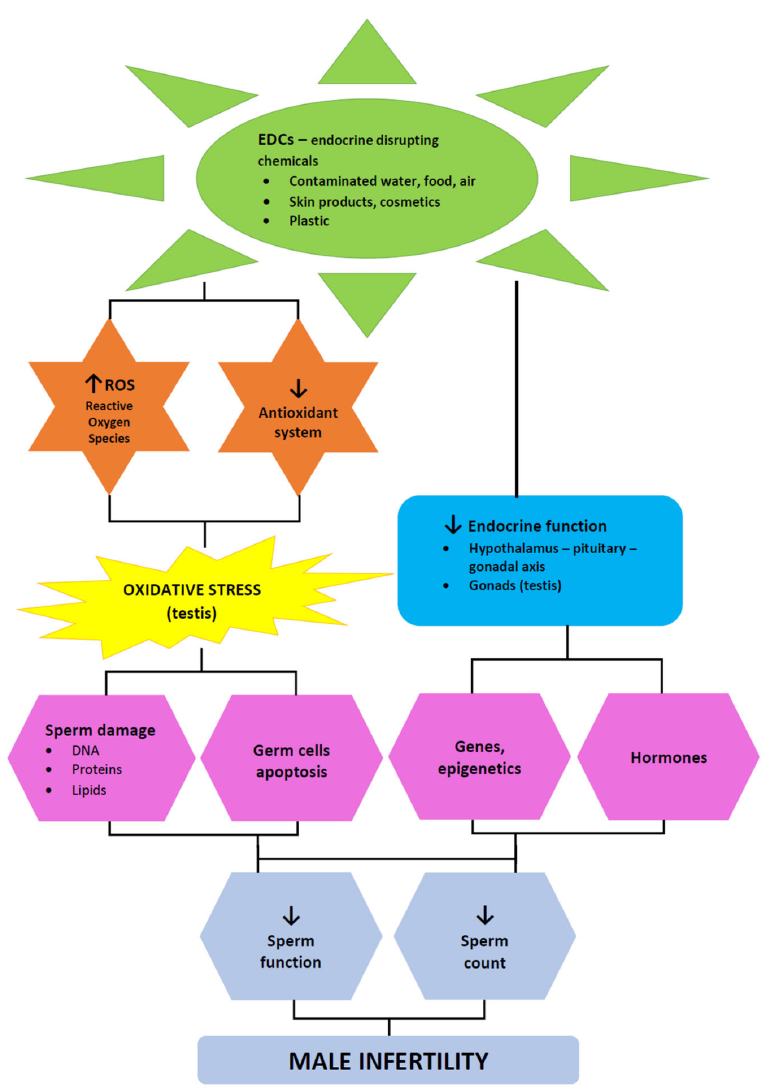
Figure 2. Mechanisms of action of endocrine ‐ disrupting chemicals (EDCs) on male fertility. EDCs may be able to bind to receptors on human spermatozoa and change sperm functions, according to mounting evidence [76]. The interaction between estrogenic compounds and nongenomic receptors for estrogen on human sperm membranes has been demonstrated. The nongenomic receptor for estradiol (E2), which is located on the sperm plasma membrane, mediates the effects of this hormone on sperm’s intracellular calcium concentrations and biological response to progesterone (P). It was shown that 17 β E2 expresses an inhibitory effect on P ‐ mediated calcium influx and acrosome reaction (AR) in human spermatozoa. The anti ‐ estrogens tamoxifen (Tx) and ICI 164,384 (ICI) induced only a slight increase in calcium influx; however, as in the case of 17 β E2, this resulted in a reduction in P ‐ stimulated calcium influx. Both agents reduced the calcium response to 17 β E2 without affecting 17 β E2-induced inhibition of the calcium response to P. Tx